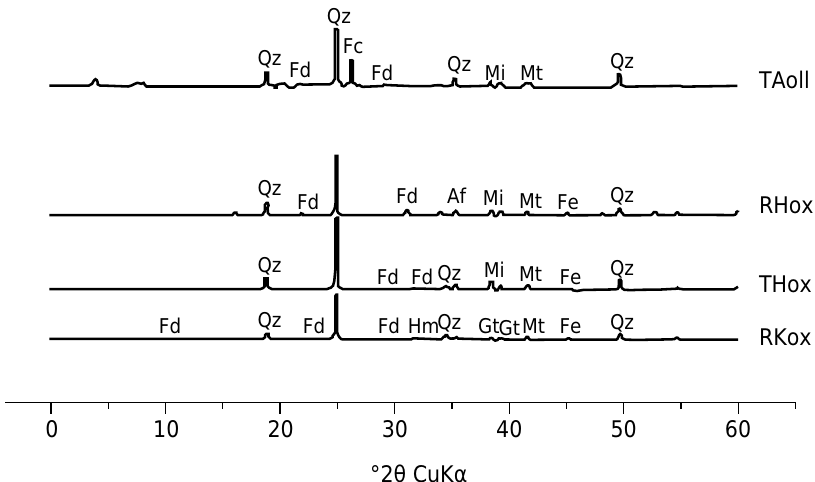
Figure 4. X ray diffraction patterns for the sandy fraction from the diagnostic soil horizons. Fd: feldspar; Fc: calcium feldspar; Qz: quartz; Af: amphibole; Mi: mica; Hm: hematite; and Mt: